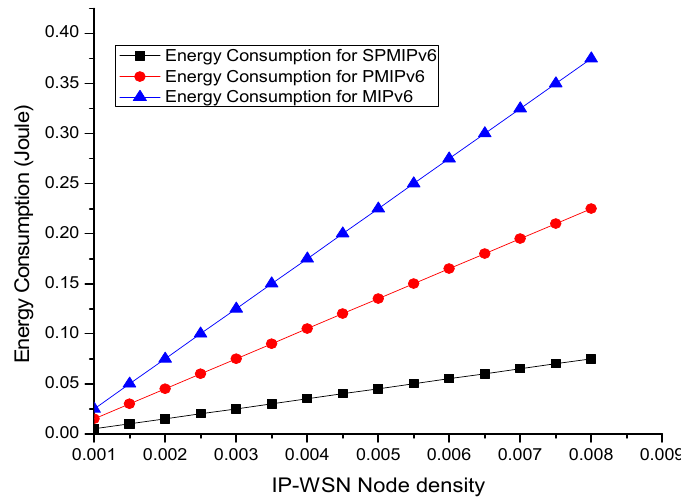
Figure 20. Node Density vs. Energy Consumptions.